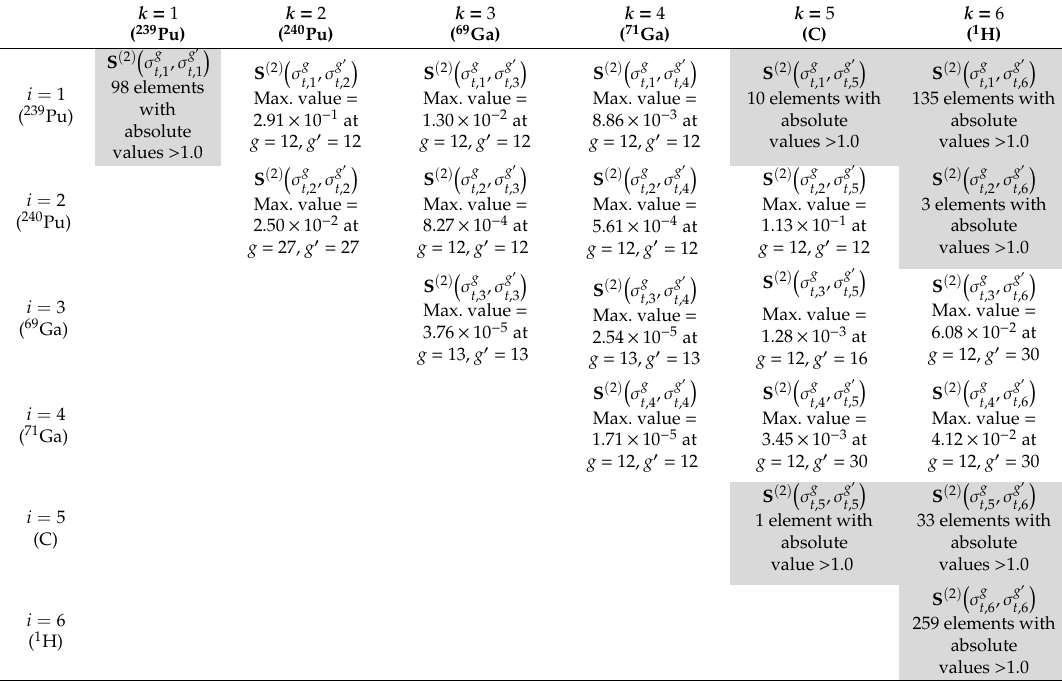
Table 4. Summary presentation of the matrix S ( 2 )